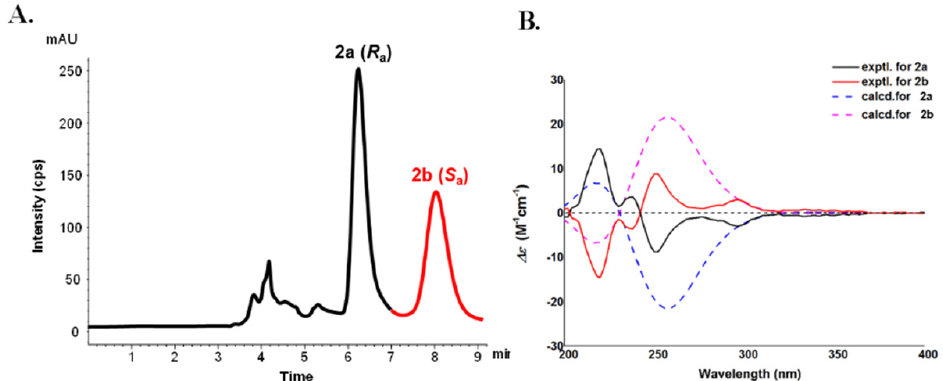
Figure 4. The chiral HPLC separation ( A ) and experimental and calculated ECD data ( B ) of com- pounds 2a and 2b .